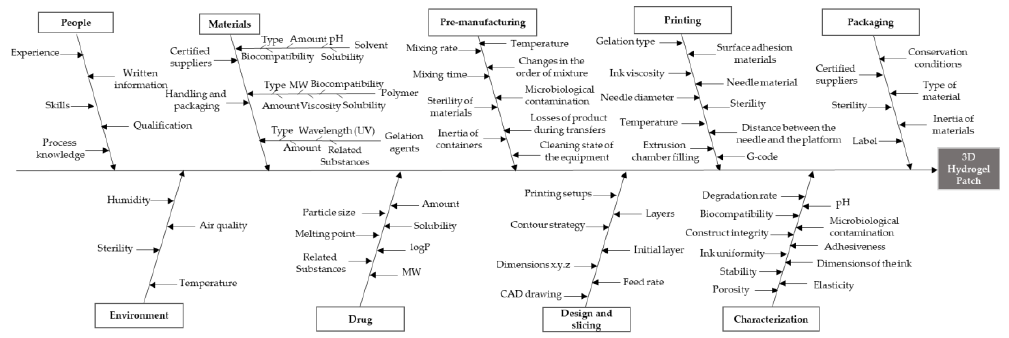
Figure 1. Ishikawa diagram illustrating factors that may have impact on the development of a 3D hydrogel patch.